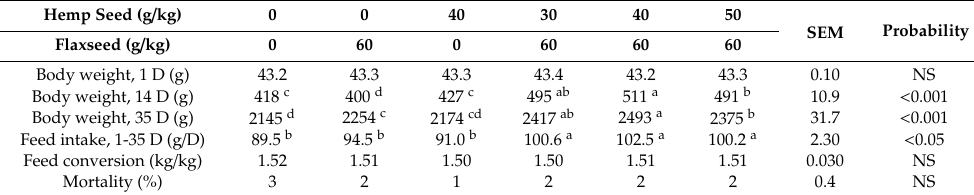
Table 4. Performance